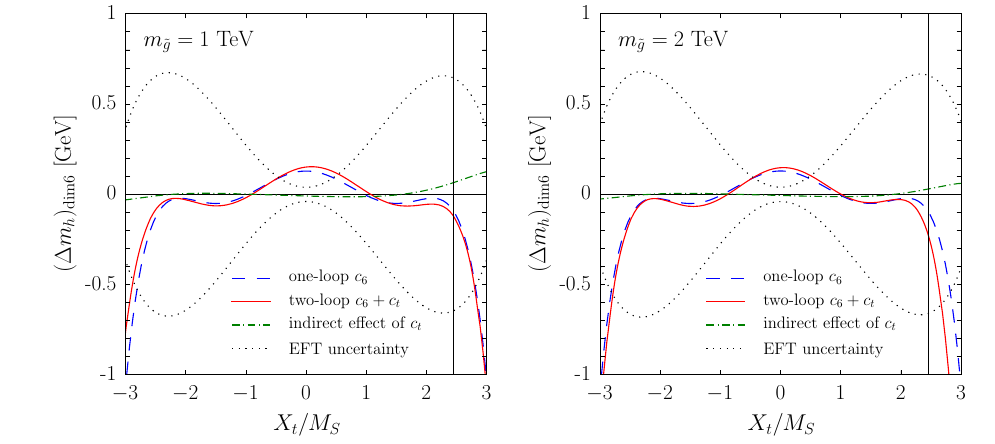
Fig. 4 Effects of dimension-six operators on the EFT prediction for the Higgs mass, as a function of the ratio X t / M S , for a common stop mass scale M S = 1 TeV. In the left plot we take m ˜ g = 1 TeV, whereas in the right plot we take m ˜ g = 2 TeV. The thin vertical lines in the two